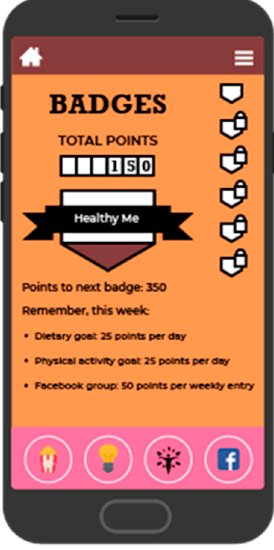
Figure 4. Screenshot of badge and point system.